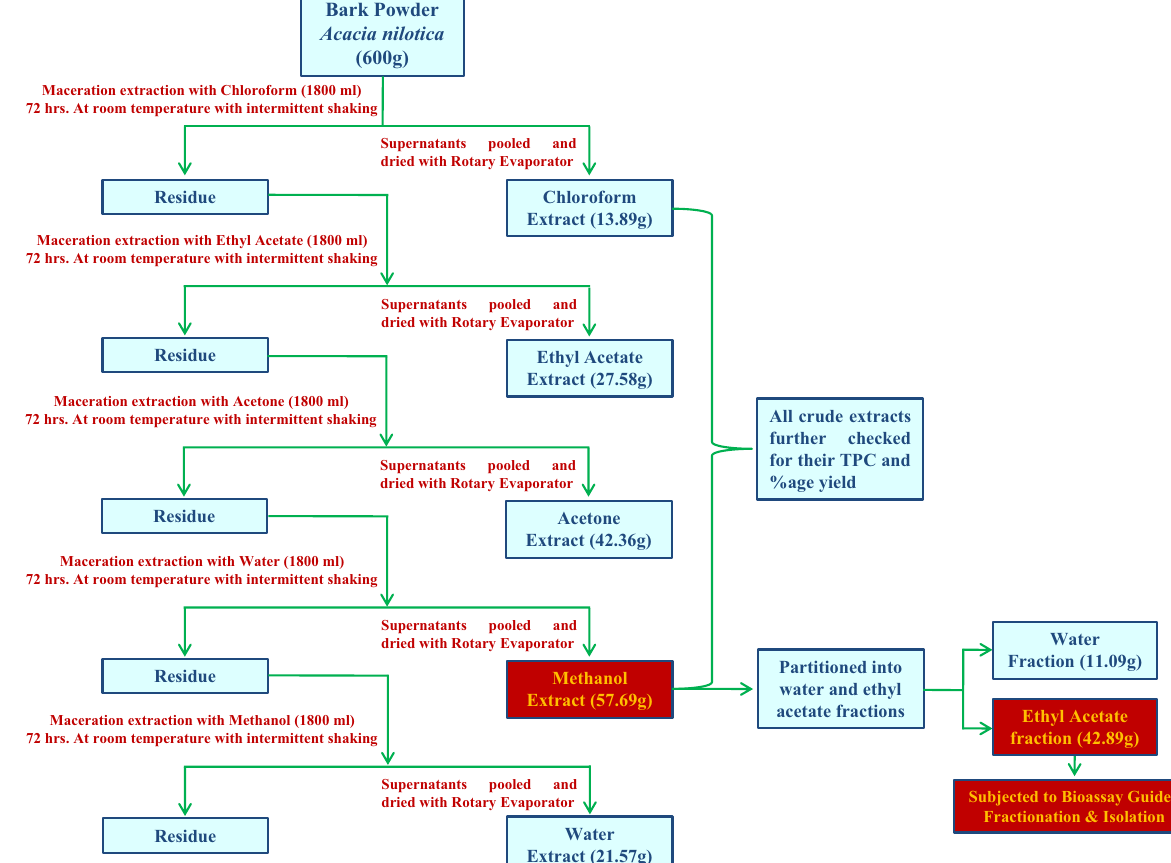
Figure 1. Extraction/fraction procedure of Methanol and other crude extracts from bark powder of Acacia